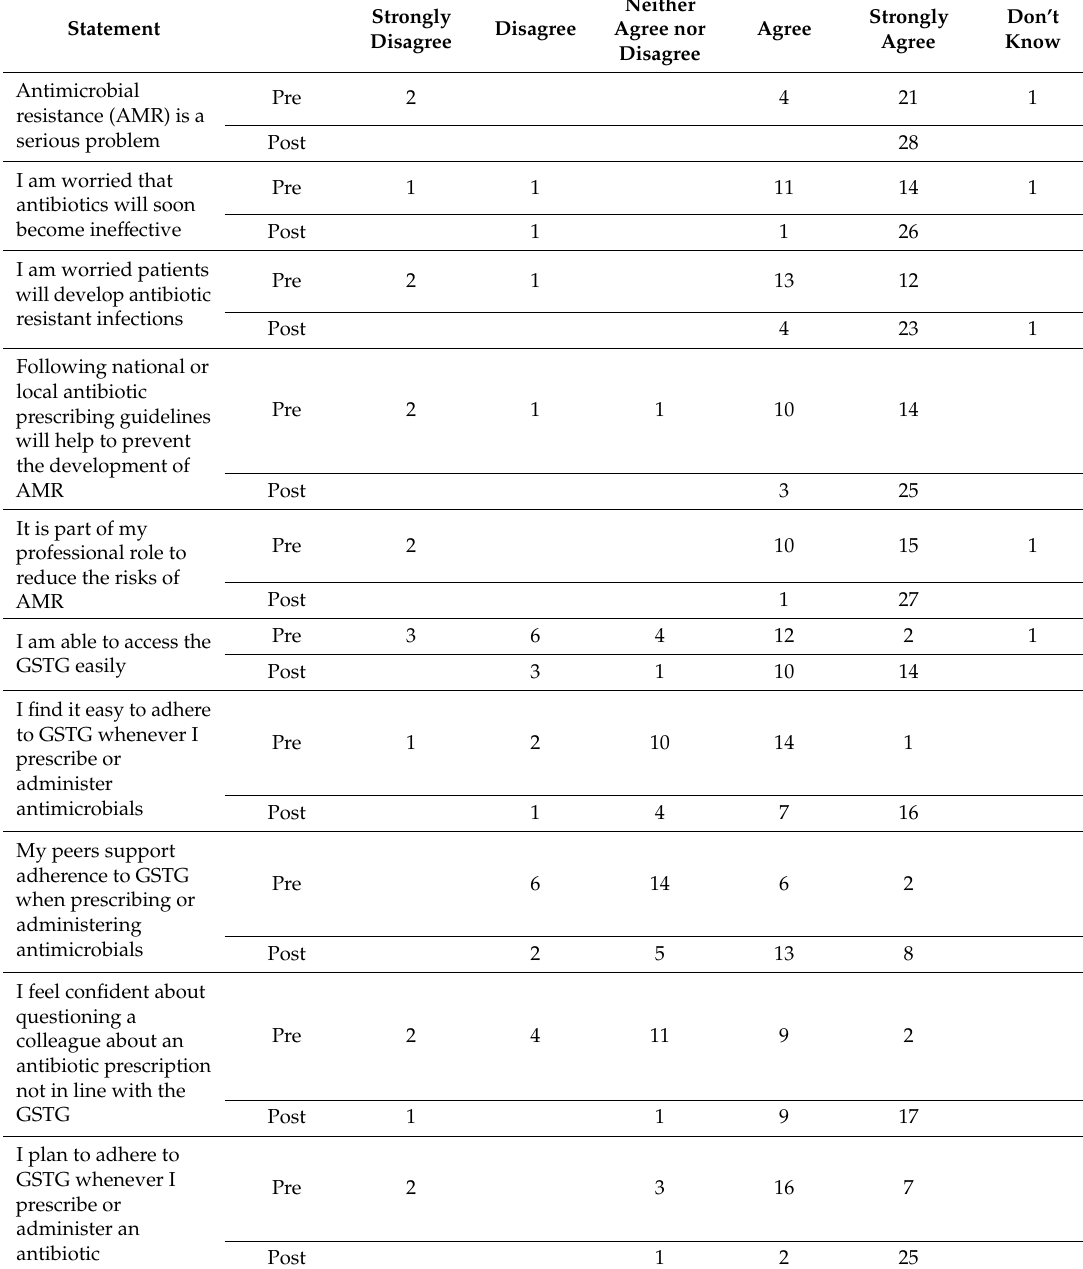
Table 4. Pre and post education responses to survey questions by sta ff at KMH (Keta Municipal